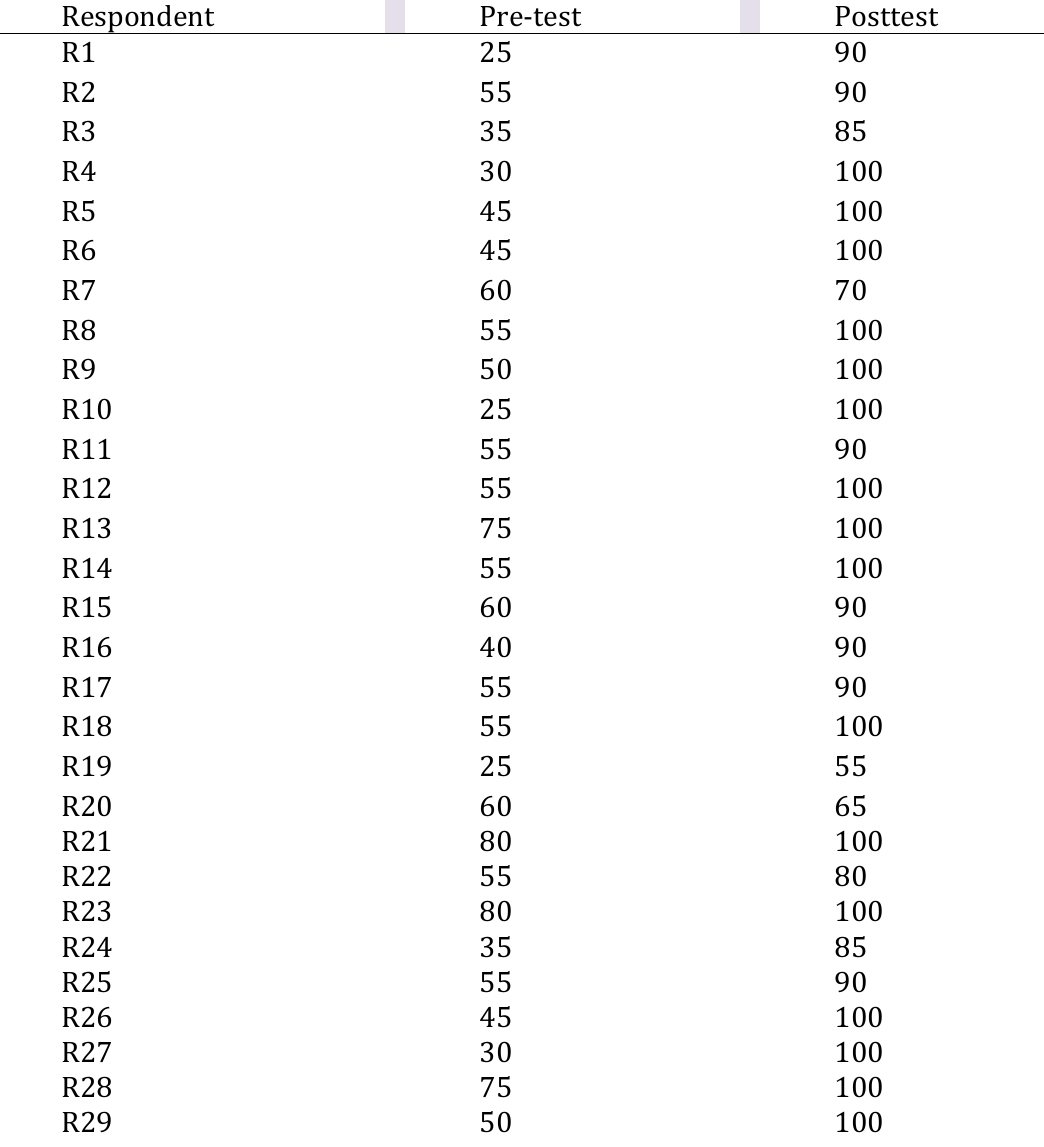
Table 4.1 the score from learners initial test and final